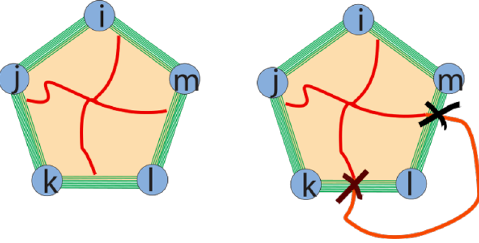
Figure 9 . At tree level the (cid:12)ve point function is just given by (3.6). As the coupling is turned